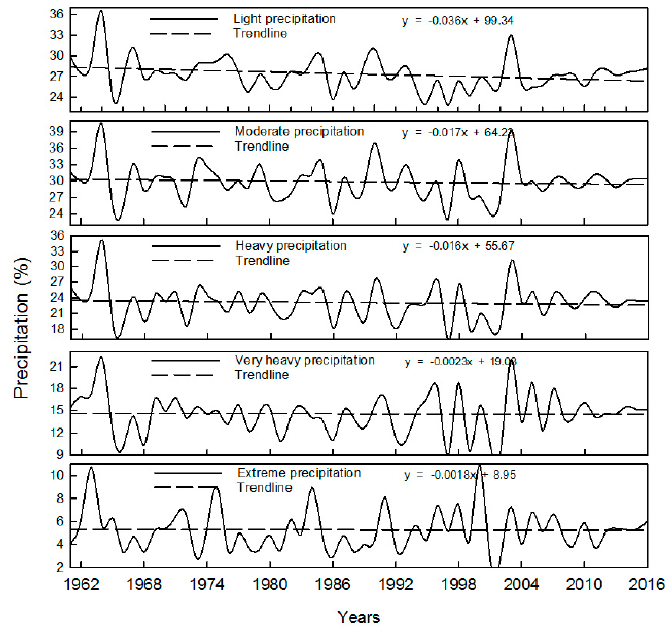
Figure 5. Ratio between precipitation of each grade and total precipitation of a whole year.